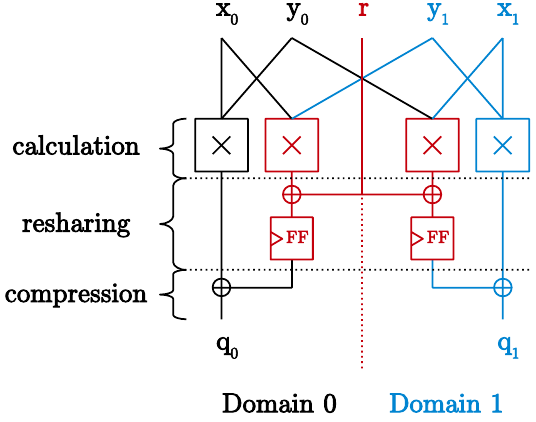
Figure 1: First-order DOM multiplier for independently shared